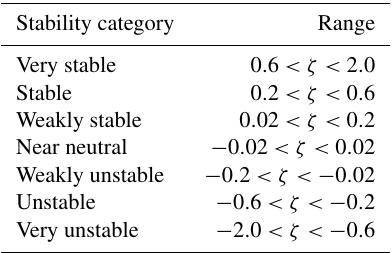
Table 3. Classification of atmospheric stability as suggested by Sor- bjan and Grachev